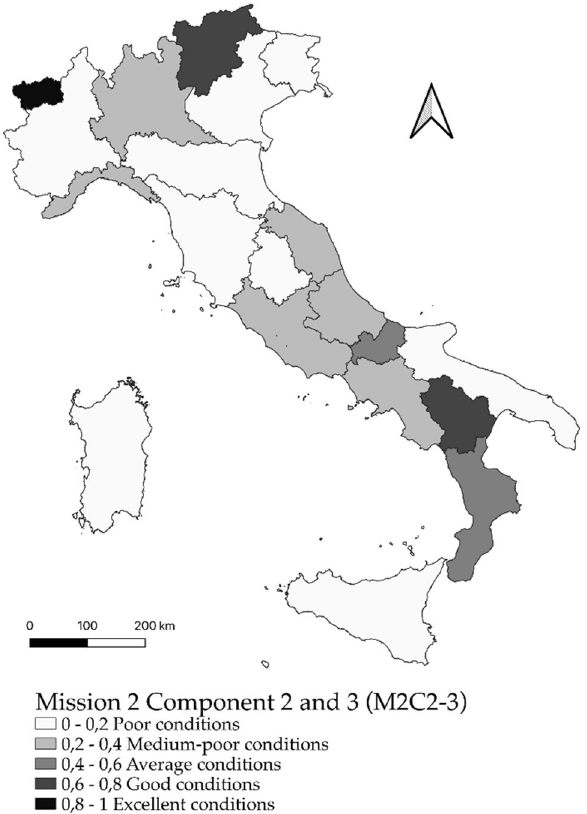
Figure 3. Territorial distribution by region of the fuzzy values for Mission 2 Components 2 (Renewable energy, hydrogen, network and sustainable mobility) and Component 3 (Energy efficiency and upgrading of